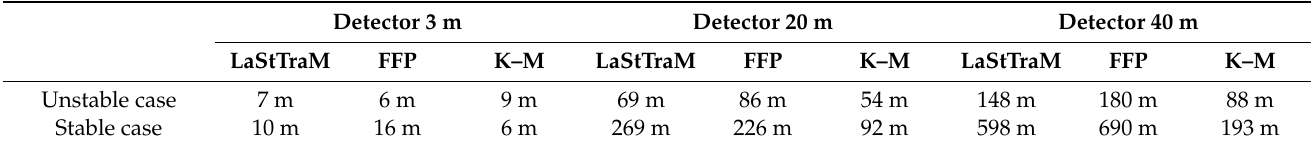
Table 3. Crosswind distance between f max and detector x max